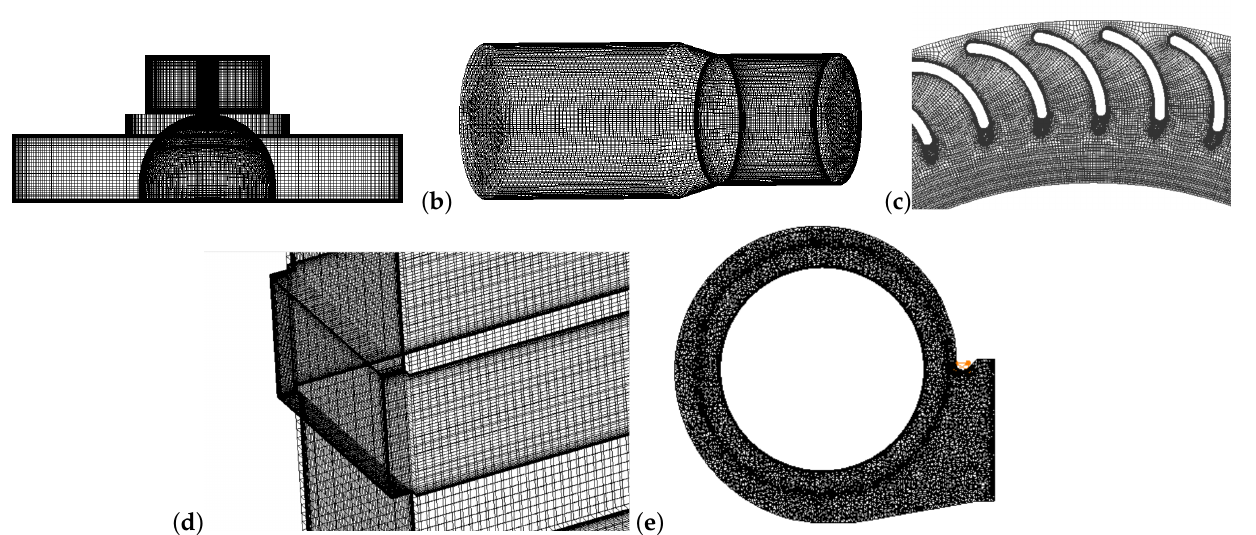
Figure 7. Schematic diagram of each component’s mesh: ( a ) entry part on the motor side, ( b ) nozzle intake, ( c ) impeller, ( d ) extension passage of volute outlet, ( e ) volute.